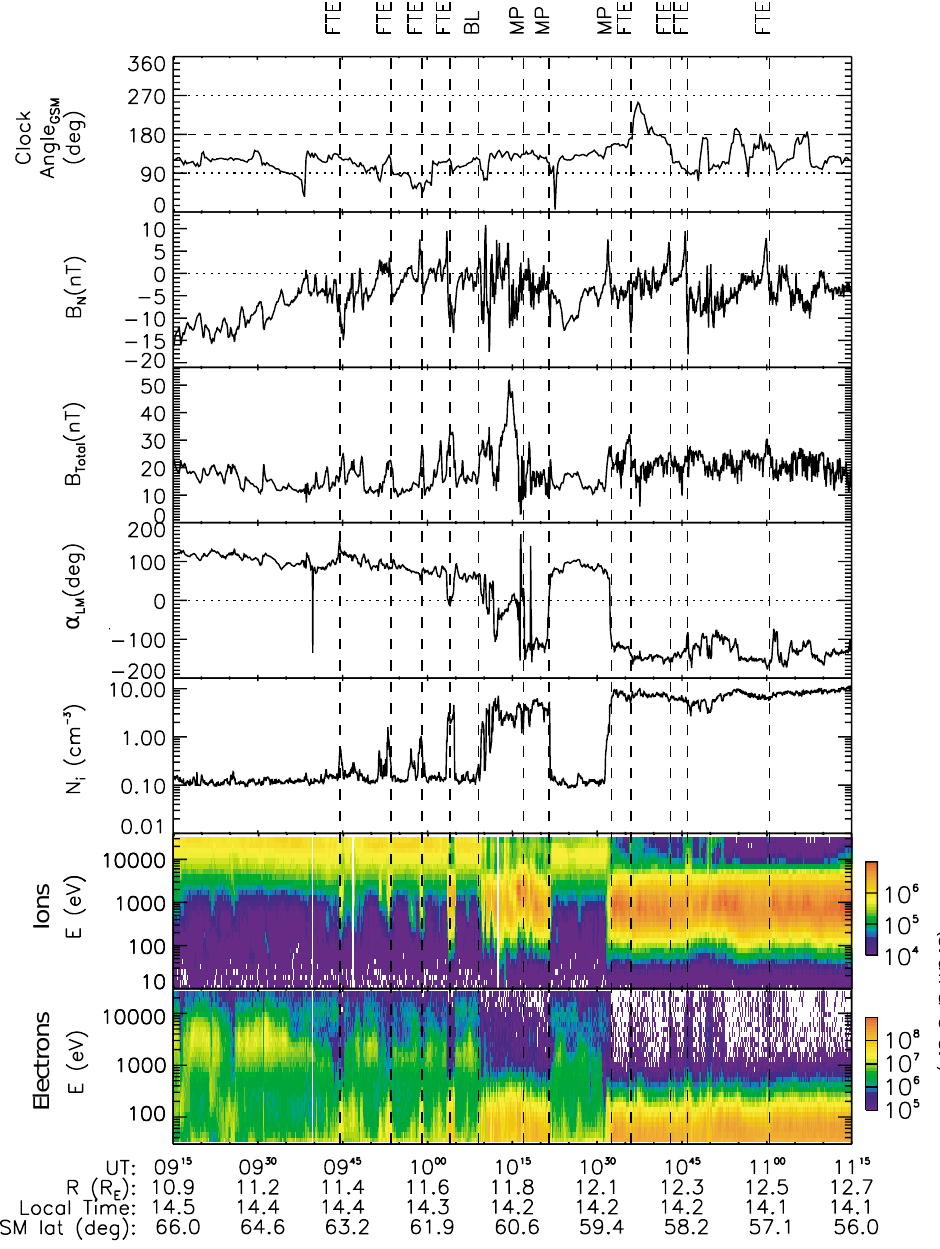
Fig. 3. Plot of ACE and Cluster data for the interval 09:15–11:15 UT on 14 February 2001. The top panel shows the clock angle of the interplanetary magnetic field measured at the ACE spacecraft and lagged by 55min such that comparisons can be made with the Cluster observation at the front of the magnetosphere. The next three panels present the component of the magnetic field normal to the magnetopause, the total magnetic field strength, and the angle of the magnetic field in the plane of the magnetopause (the α LM parameter) measured by the FGM instrument on board the Cluster 1 (Rumba) spacecraft. The fifth and sixth panels present the total ion density profile and ion energy- time spectrogram (all pitch angles) observed by the CIS2 (HIA) instrument on Cluster 1. Finally, the lower panel presents the electron energy distribution measured in the field-parallel direction by the PEACE HEEA sensor, also on Cluster 1. Overlaid on this figure (dashed lines) are the times of events originally identified by Wild et al. (2001) and discussed in the text. Specifically, the centre times of four magnetospheric FTEs, the entry into the boundary layer (BL), three crossings of the magnetopause (MP), and four magnetosheath FTEs are indicated.